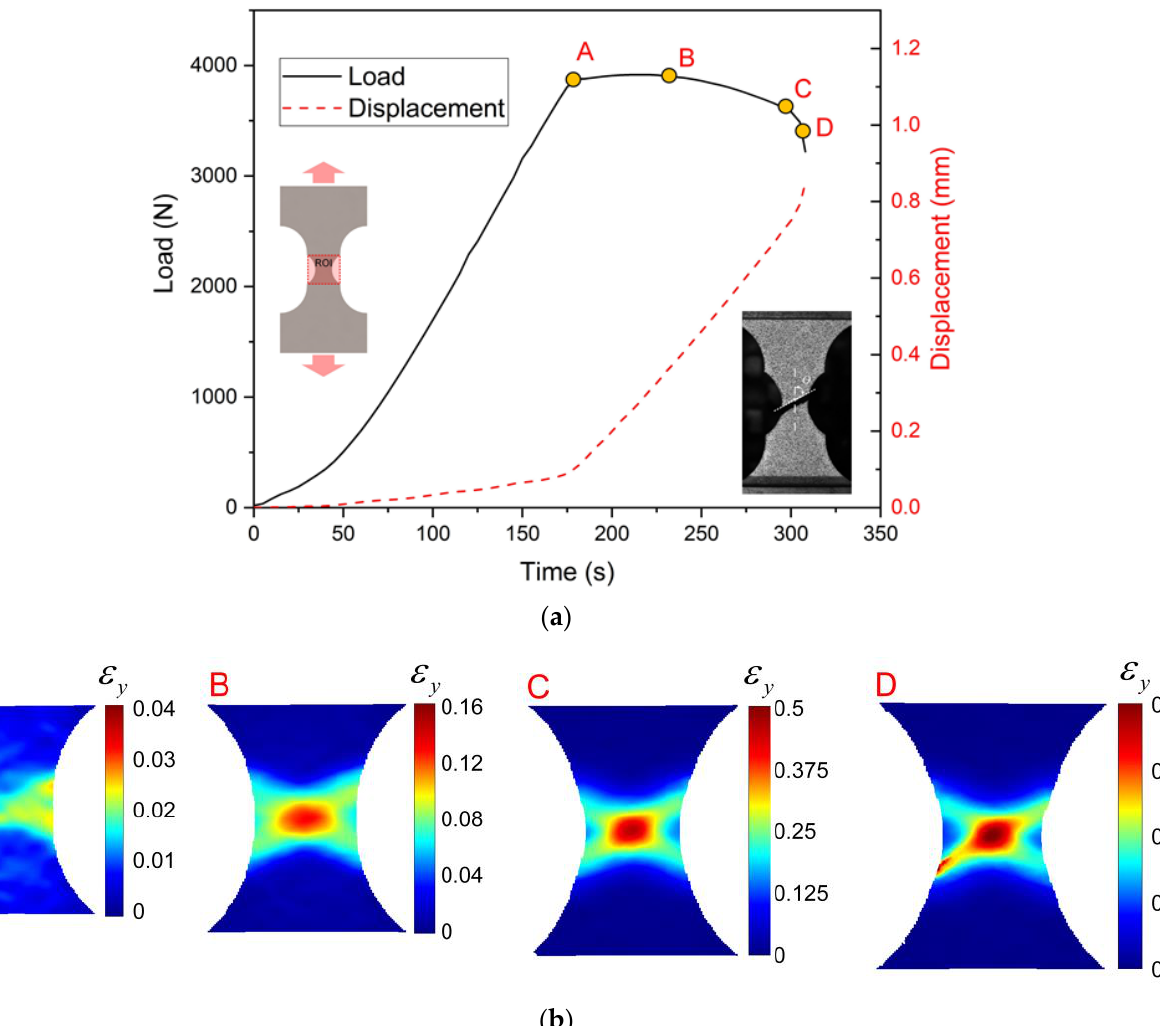
Figure 8. Loading curves and the strain fields in the notched tension sample (R = 5 mm) test: ( a ) Load— time and displacement—time curves; ( b ) apparent strain fields ε y at different loading stages.